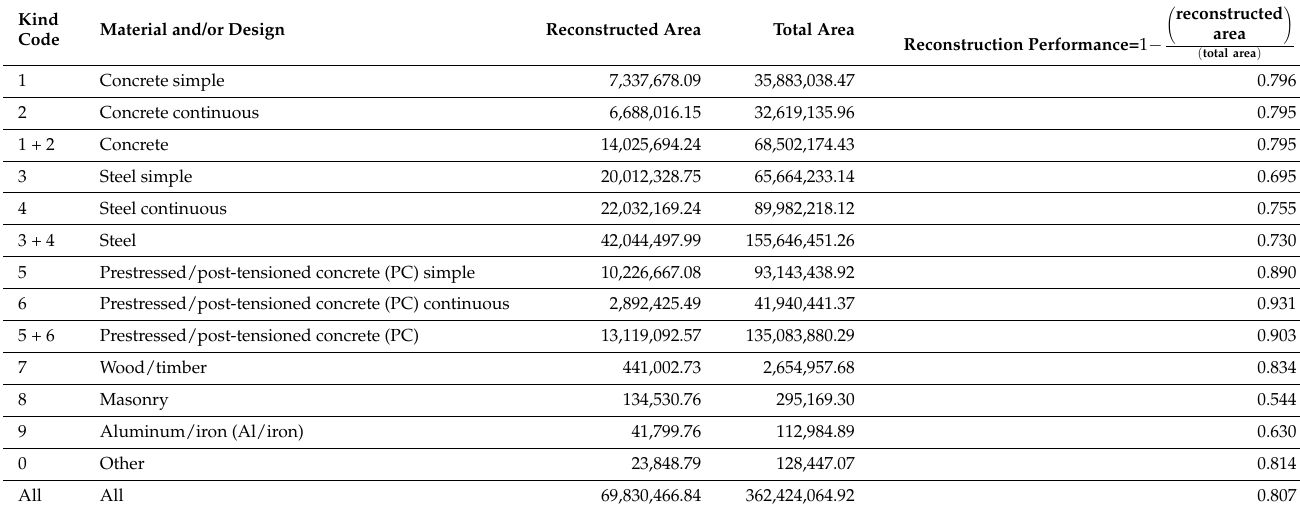
Table 2. Reconstruction performances of bridge materials by